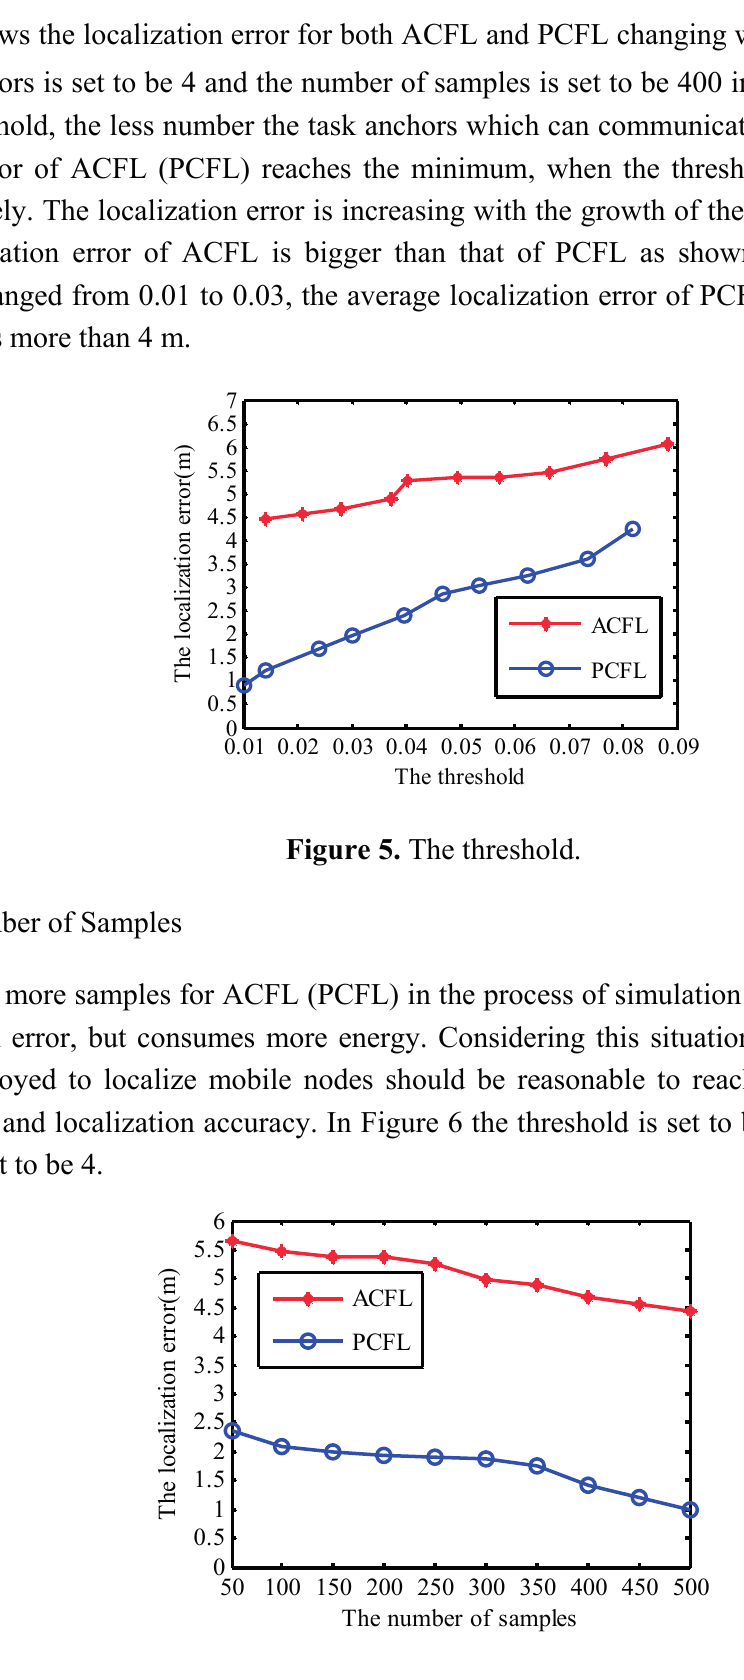
Figure 6. The number of